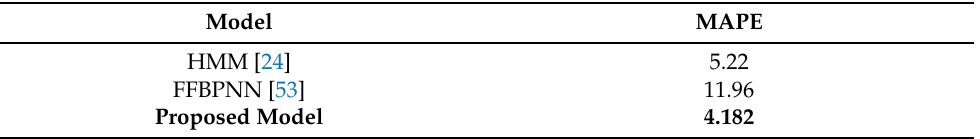
Table 7. Comparison of the proposed ensemble model with state-of-art techniques (using same multi-residential buildings